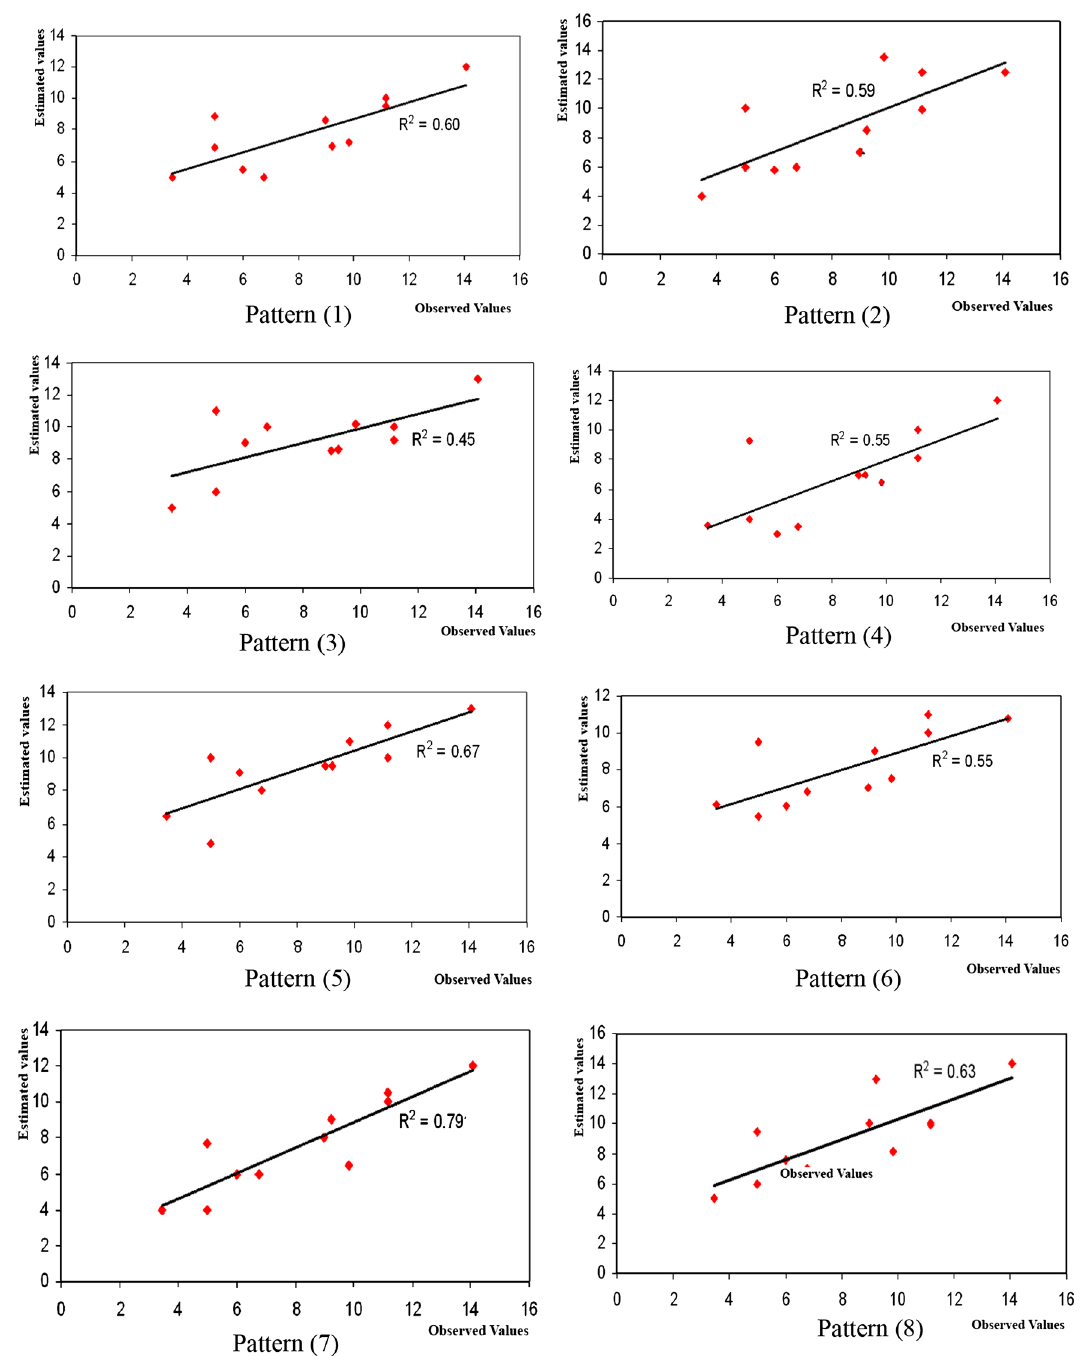
Fig. 6 Comparison between the estimated and observed values of the alluvial springs discharge in the different network